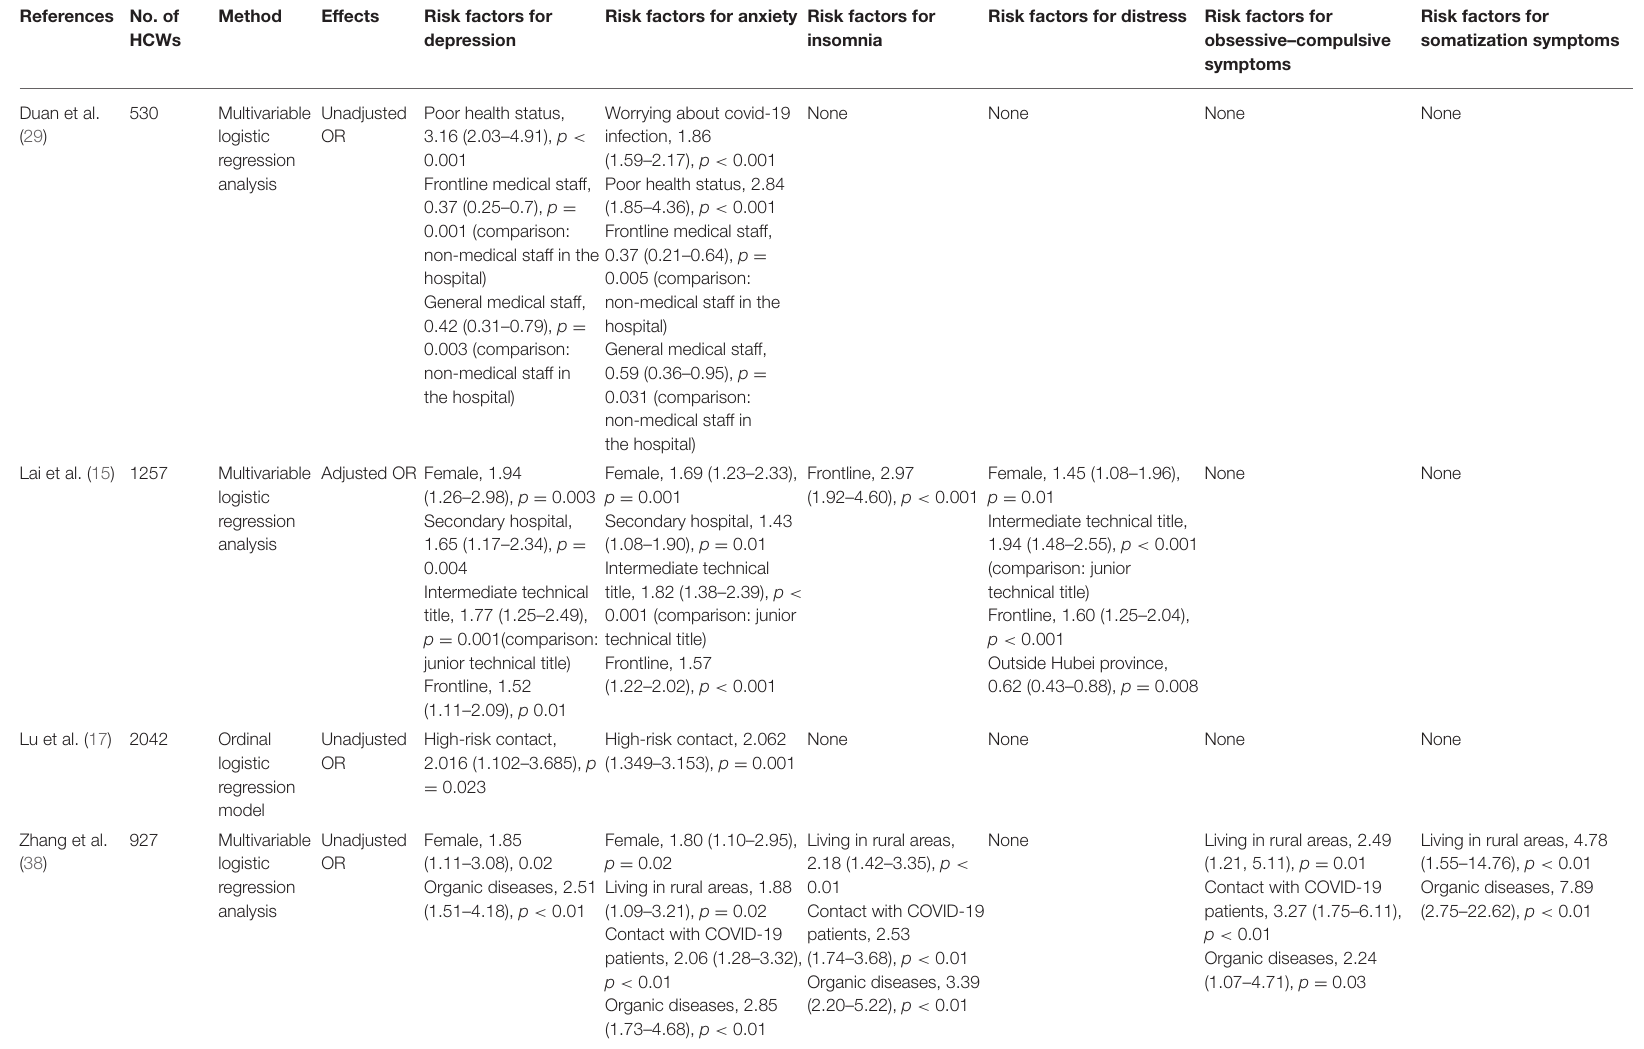
TABLE 2 | Risk factors of mental health problems among healthcare workers during the COVID-19 pandemic. References No. of